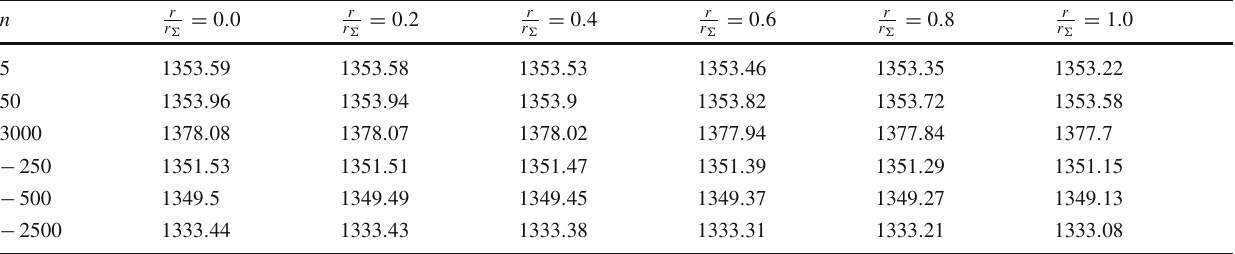
Table 3 Matter density ρ in MeV fm − 3 unit are obtained by fixing b = 0 . 0095 for a compact star of mass M = 1 . 85 M (cid:3) and radius = 9 . 5 km. for different values of